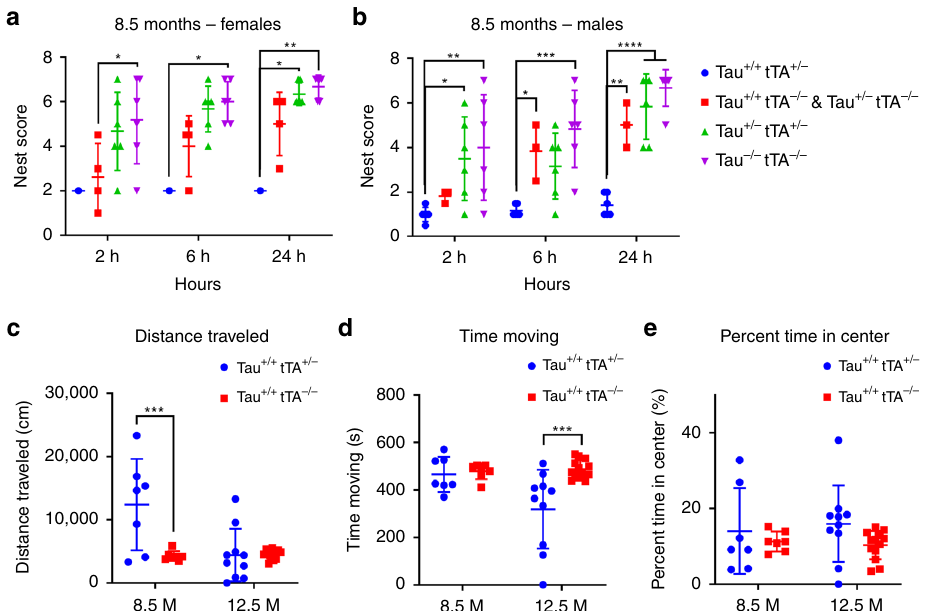
Fig. 7 Nesting and open fi eld behavior in rT2/T2 mice. a , b At 8.5 months of age, rT2/T2 ( n = 7), rT2 ( n = 12), and control littermates (Tau + / + tTA − / − n = 7, Tau − / − tTA − / − n = 12) were tested for their natural ability to construct a well-structured nest, which was scored 2, 6, and 24 h after presenting the mice with a fresh nestlet. An overall sex effect was detected indicating that females tended to build better nests than males. Therefore, each sex was analyzed separately. An impairment in nesting was observed in both male and female rT2/T2 mice, with rT2 mice performing signi fi cantly better than rT2/T2 mice by 24 h. For females ( a ), a two-way ANOVA revealed a signi fi cant main effect of genotype ( F (3, 39) = 12.81, p < 0.0001). For males ( b ), a two-way ANOVA also revealed a signi fi cant main effect of genotype ( F (3, 51) = 28.18, p < 0.0001). Tukey ’ s multiple comparisons test were run to compare genotypes within time points. c – e rT2/T2 and control littermates were tested in the open fi eld at 8.5 months of age ( n = 7 per group) and at 12.5 months of age (Tau + / + tTA + / − n = 10, Tau − / − tTA − / − n = 13). rT2/T2 mice exhibit signs of hyperactivity in that they travel signi fi cantly farther in the open fi eld than controls at 8.5 months (two-way ANOVA: F (1, 33) = 9.395, main effect of genotype p = 0.0043), however, this declines to normal distance by 12.5 months ( c ). This shorter distance traveled at 12.5 months is re fl ected in less time spent moving (two-way ANOVA: F (1, 33) = 7.748, main effect